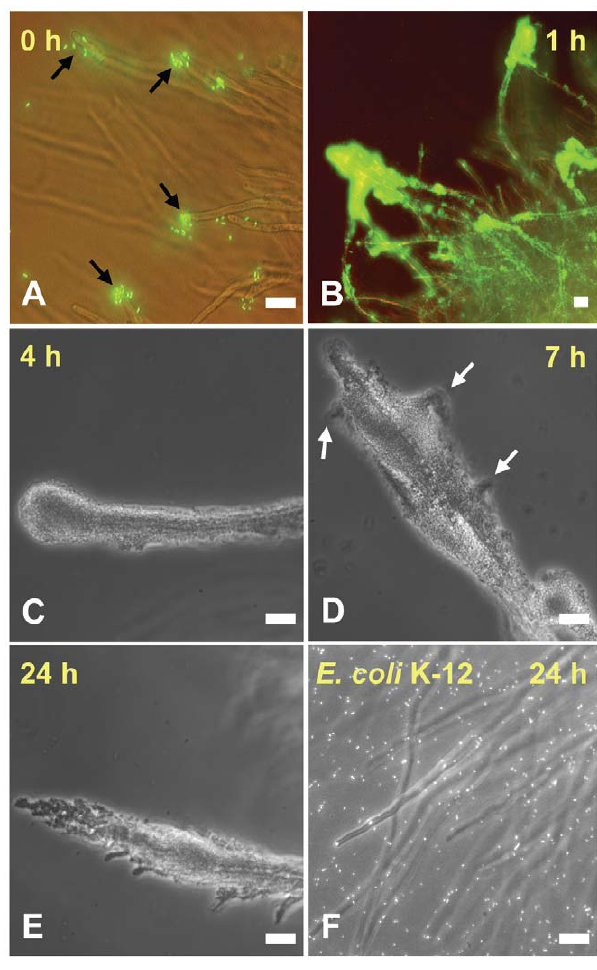
Figure 1. Time course of interaction of S . Typhimurium with A. niger hyphae. GFP- S . Typhimurium cells attached rapidly to the tip of the fungal hyphae (A, black arrows), where large biofilms formed within 1 h of incubation (B). The biofilm coated the entire hyphae by 4 h (C) and began to differentiate by 7 h (D, white arrows). Distinct branching of the biofilm was visible by 24 h (E). E. coli K-12 (stained with SYTO9 H ) did not display any significant attachment to the hyphae by 24 h (F). Scale bars, 20 m